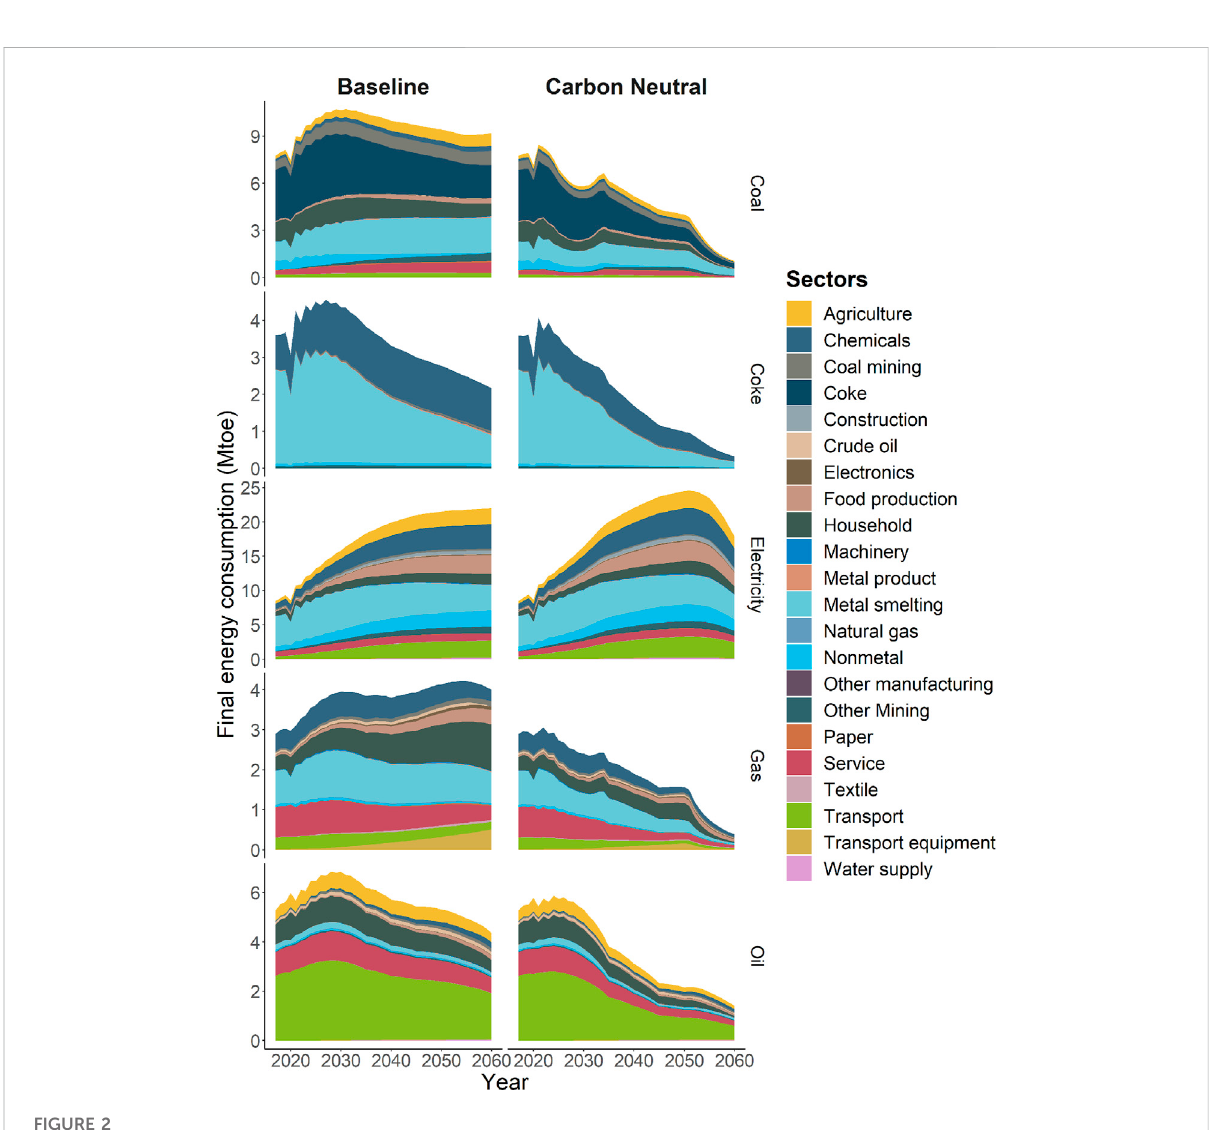
FIGURE 2 Final energy consumption by sector and by energy in